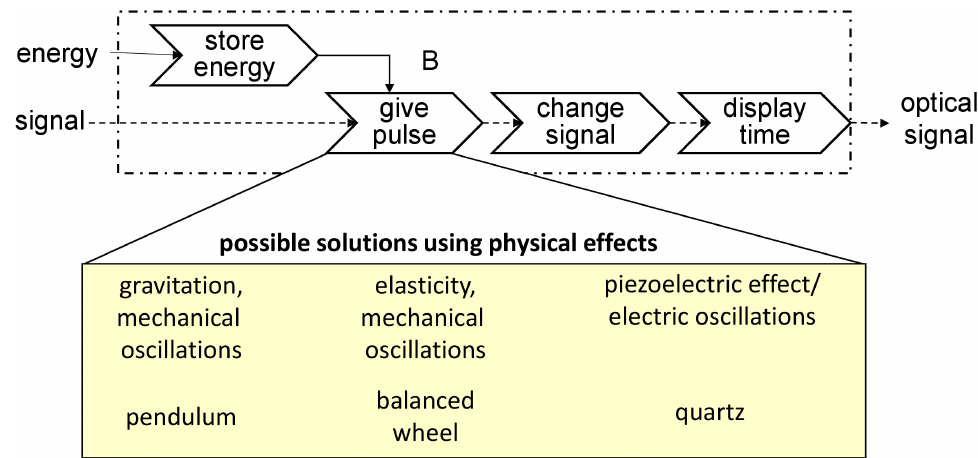
Figure 9. Example for physical phenomena for the realization of a function of a watch.